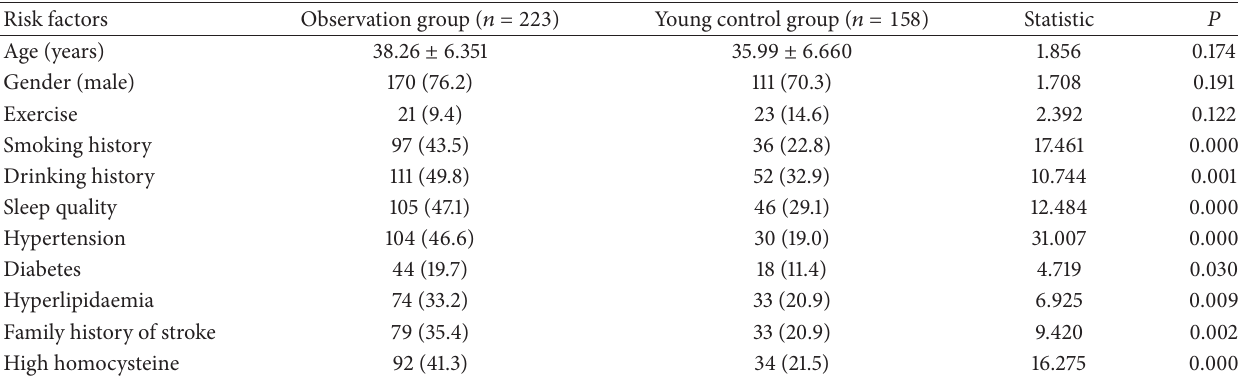
Table 1: Risk factors analysis for observation group and youth control group. By univariate analysis, smoking history, drinking history, sleep quality, hypertension, diabetes, hyperlipidaemia, family history of stroke, and high homocysteine were statistically different between youth IS patients and youth control cases ( 𝑃 < 0.05 ).